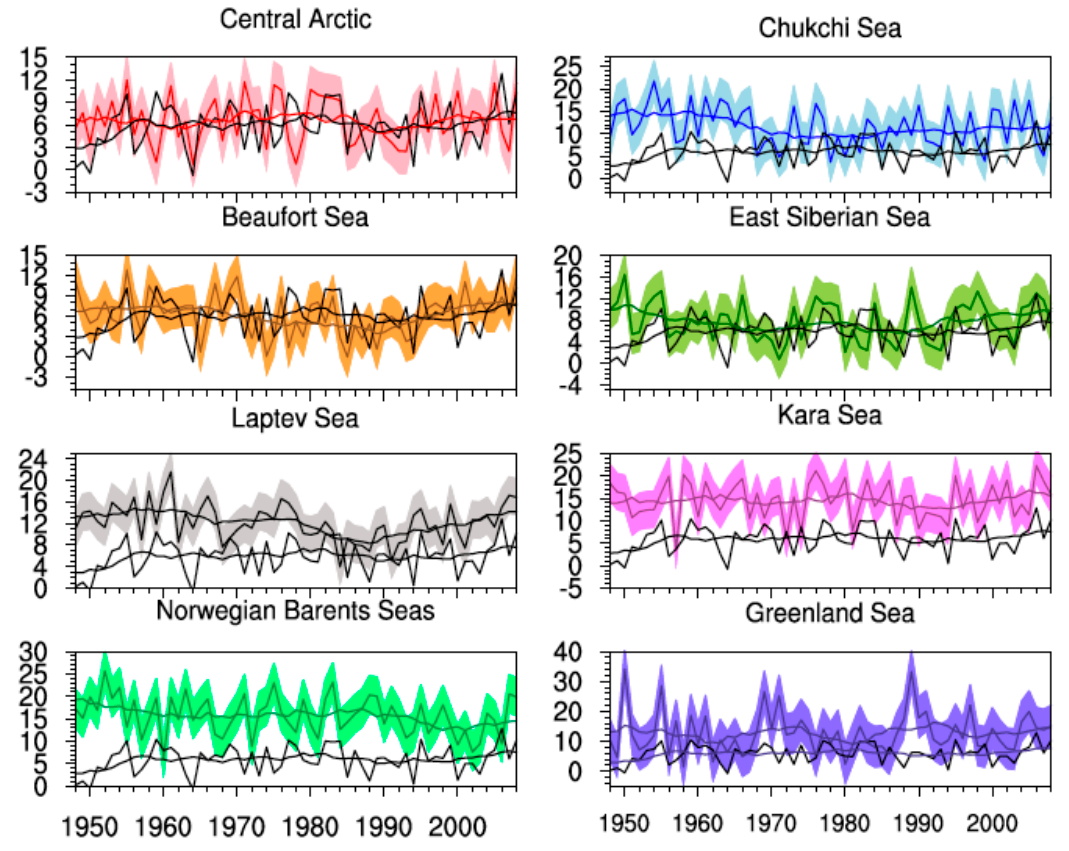
Figure 3. The same as Figure 2, but for storm intensities. Unit: hPa.